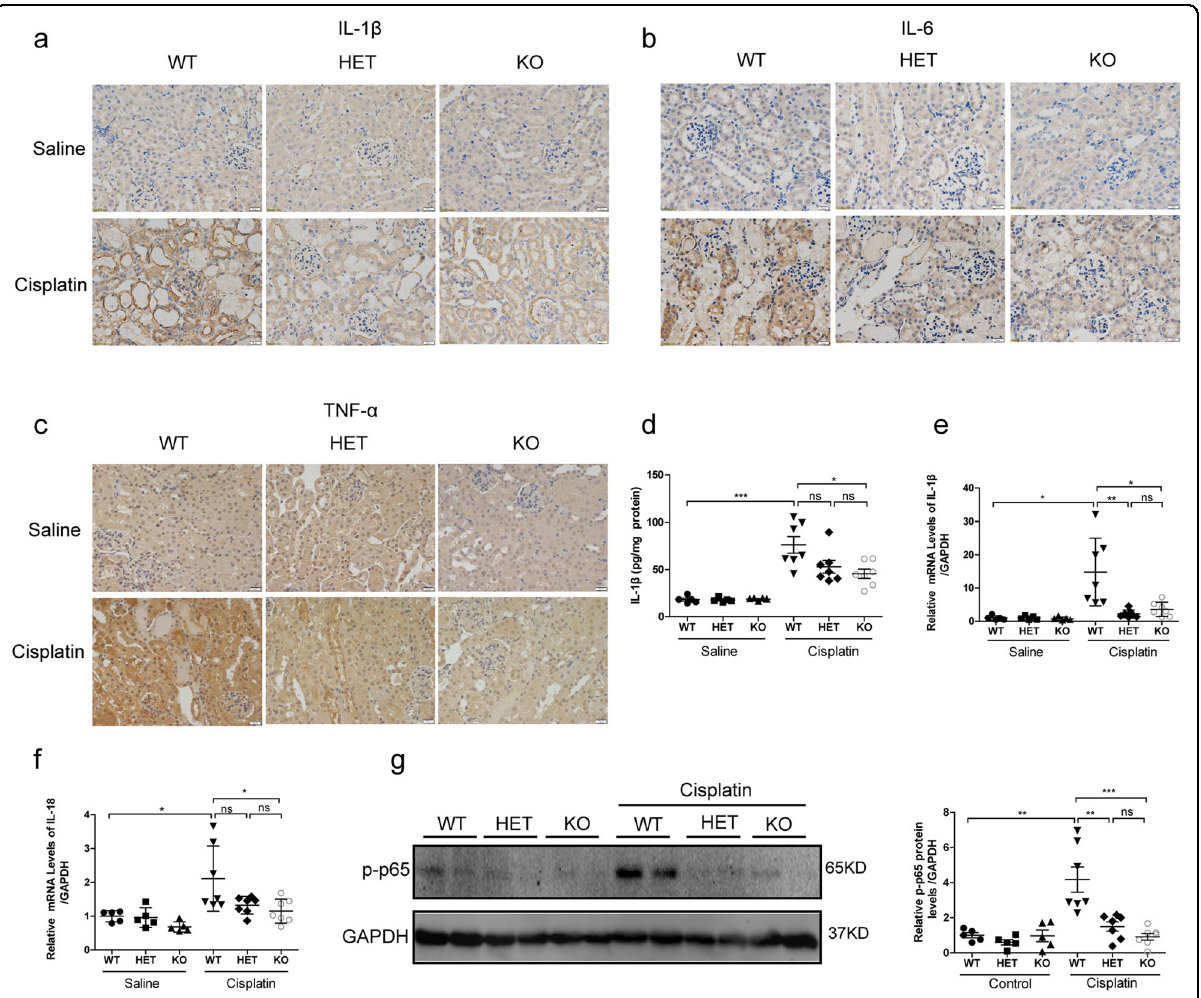
Fig. 3 GSDME deletion extenuated cisplatin-induced in fl ammation in kidney. a – c Immunohistochemical staining of IL-1 β , IL-6, and TNF- α (scale bar = 20 μ m). d Renal production of IL-1 β detected by ELISA. e , f Transcriptional levels of IL-1 β and IL-18 in mouse kidney tissues. g p-p65 protein levels in mouse kidney tissues. * P < 0.05, ** P < 0.01, and *** P <